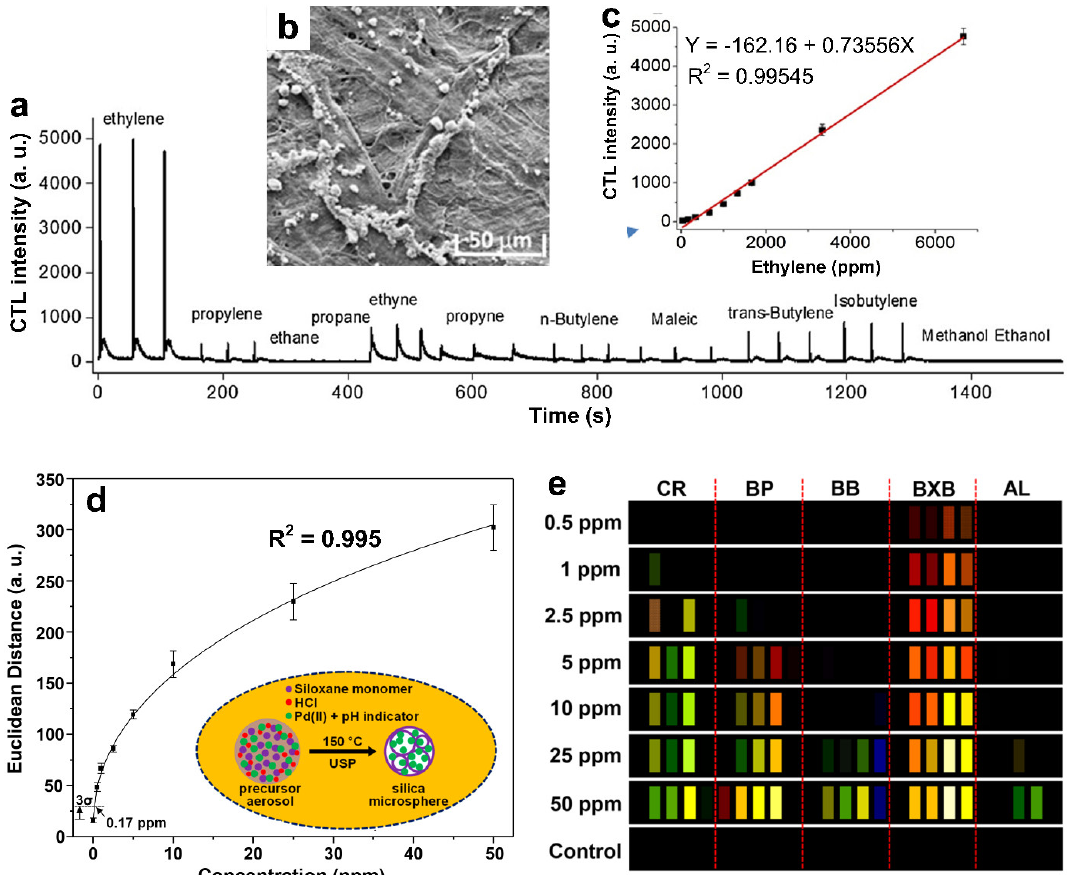
Figure 4. ( a ) CTL signals of a variety of hydrocarbons with a sample concentration of 0.67 vol%. ( b ) SEM image of the nanostructured 0.32 wt% Mn 2+ /SiO 2 on weighing paper. ( c ) The CTL sensor performance towards ethylene gas detection in terms of the luminescent intensity versus gas concen- tration. Reproduced from Ref. [40] with permission from Elsevier. ( d ) Calculated response (Euclidean distance) as a function of ethylene gas concentration with an exposure time of 20 min. Inset: the schematic diagram of the colorimetric ink preparation via ultrasonic spray pyrolysis (USP). ( e ) The different color profiles of the colorimetric sensor arrays upon exposure to ethylene gas ranged from 0.5 to 5 ppm for 2 min. Reproduced from Ref. [41] with permission from the American Chemical